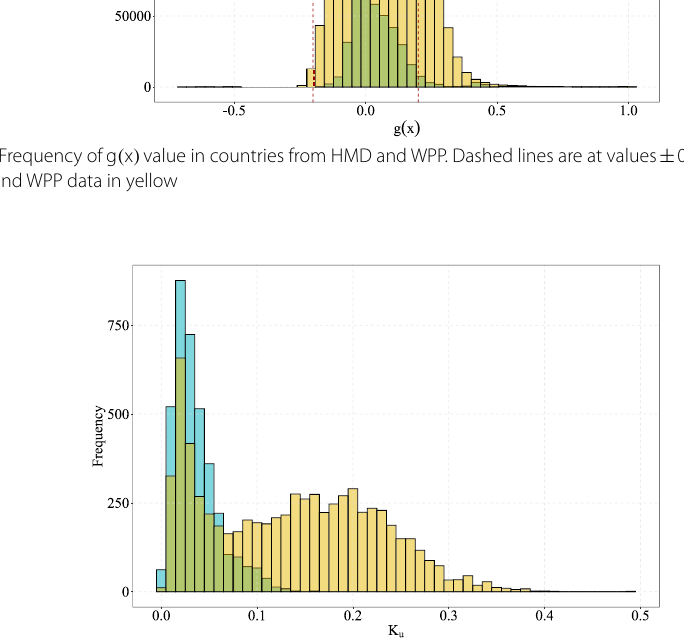
Fig. 5 Frequency of K u value in countries from HMD and WPP. HMD data in green (or blue) and WPP data in